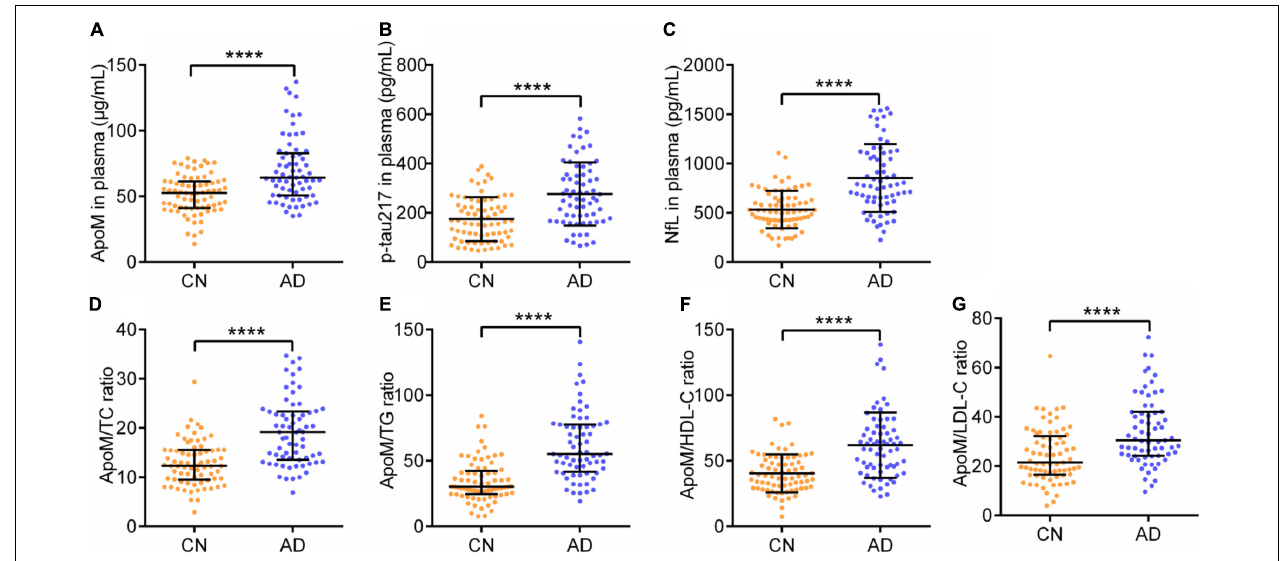
FIGURE 1 | Plasma levels of ApoM, p-tau217, NfL, and ApoM-derived indicators between two groups. ApoM, apolipoprotein M; p-tau217, tau phosphorylated at threonine 217; NfL, neurofilament light chain; CN, cognitively normal; AD, Alzheimer’s disease; TC, total cholesterol; TG, triglyceride; HDL-C, high-density lipoprotein cholesterol; LDL-C, low-density lipoprotein cholesterol; SD, standard deviation; IQR, interquartile range. Median with IQR (A,D,E,G) and mean ± SD (B,C,F) . Statistical comparison was performed using Mann–Whitney U test (A,D,E,G) or Student’s t -test (B,C,F) . **** p ≤ 0.0001. p < 0.05 was considered the statistical significance.